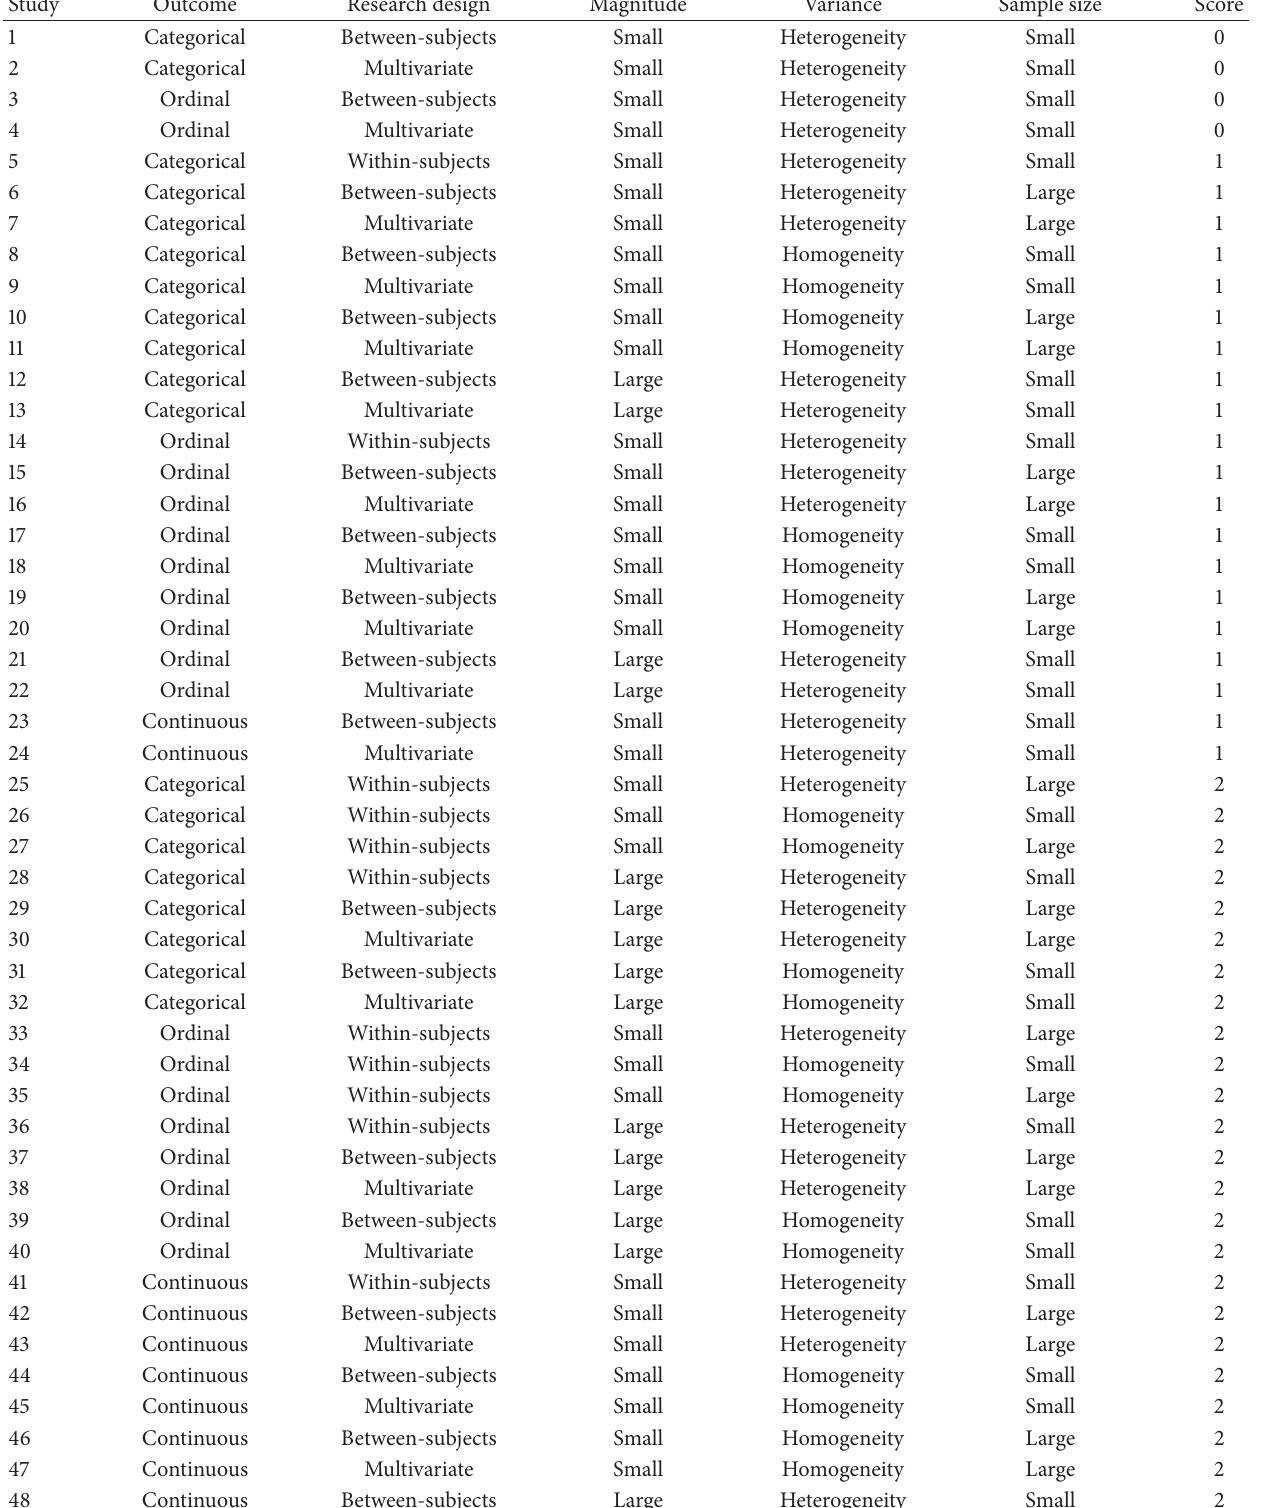
Table 2: Scoring methodology for statistical